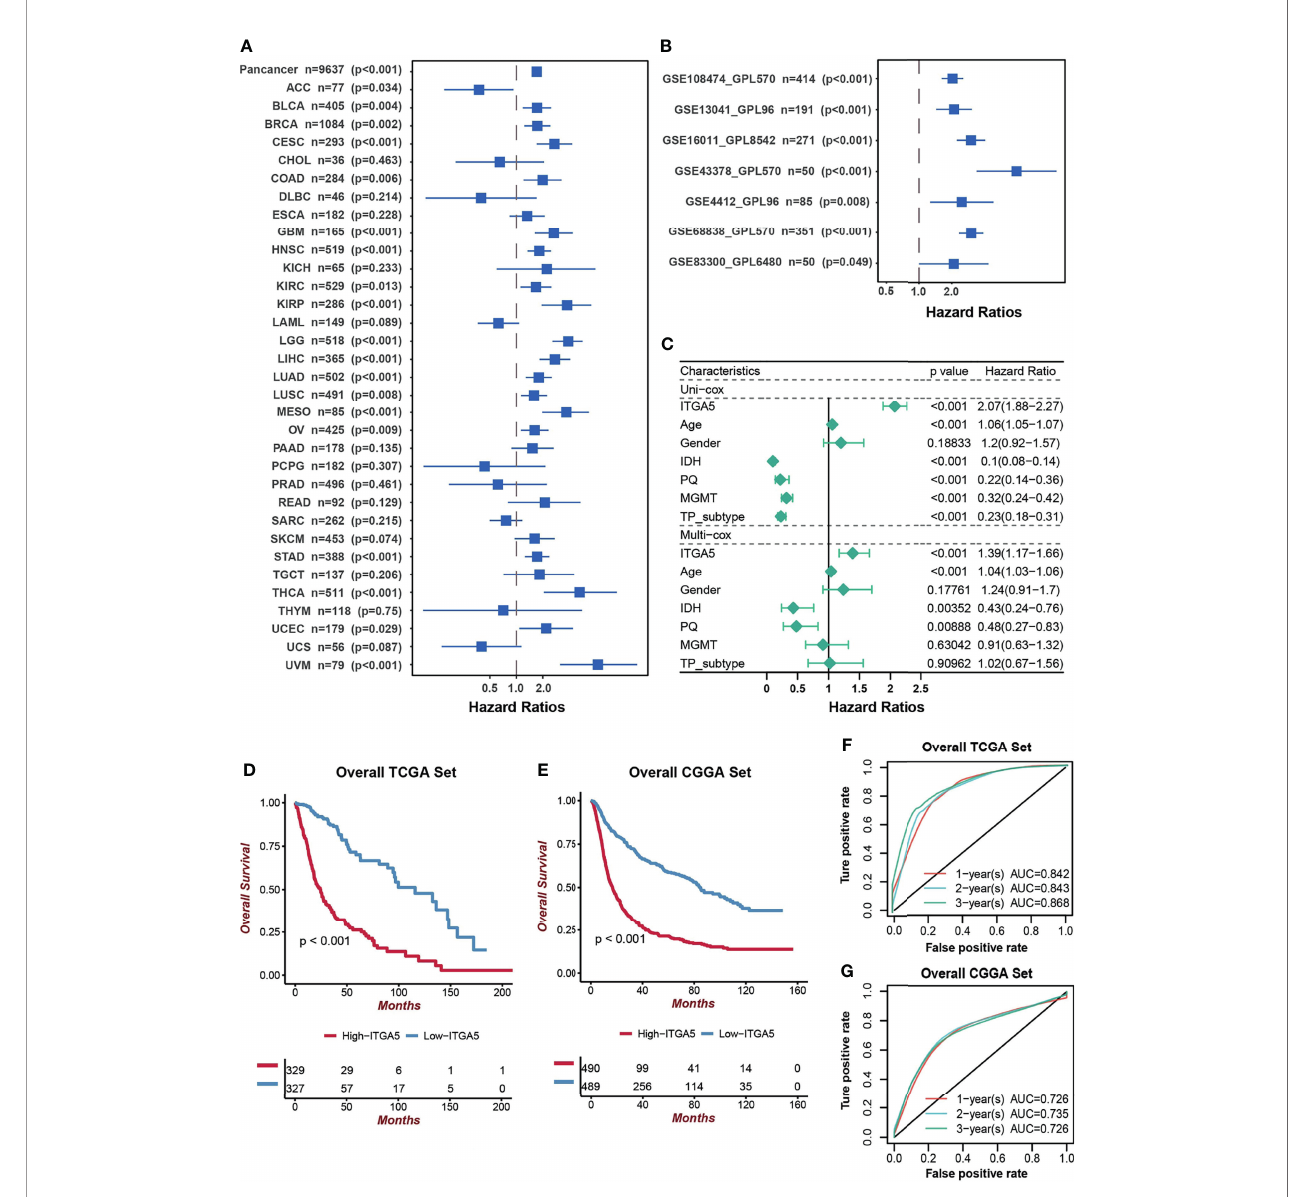
FIGURE 2 | The prognostic potential of ITGA5. (A) Univariate cox analysis of ITGA5 for overall survival of patients in the TCGA pan-cancer cohorts. (B) Univariate Cox analysis for overall survival of patients with gliomas based on the GEO datasets. (C) The forest plot of univariate and multivariate cox proportional hazard ratios for ITGA5 based on the TCGA dataset. (D) Kaplan – Meier curves for high and low ITGA5 level groups in the TCGA. (E) Kaplan – Meier curves for high and low ITGA5 level groups in the CGGA. (F) The time-dependent receiver operating characteristic curve of ITGA5 from the TCGA. (G) The time-dependent receiver operating characteristic curve of ITGA5 from the